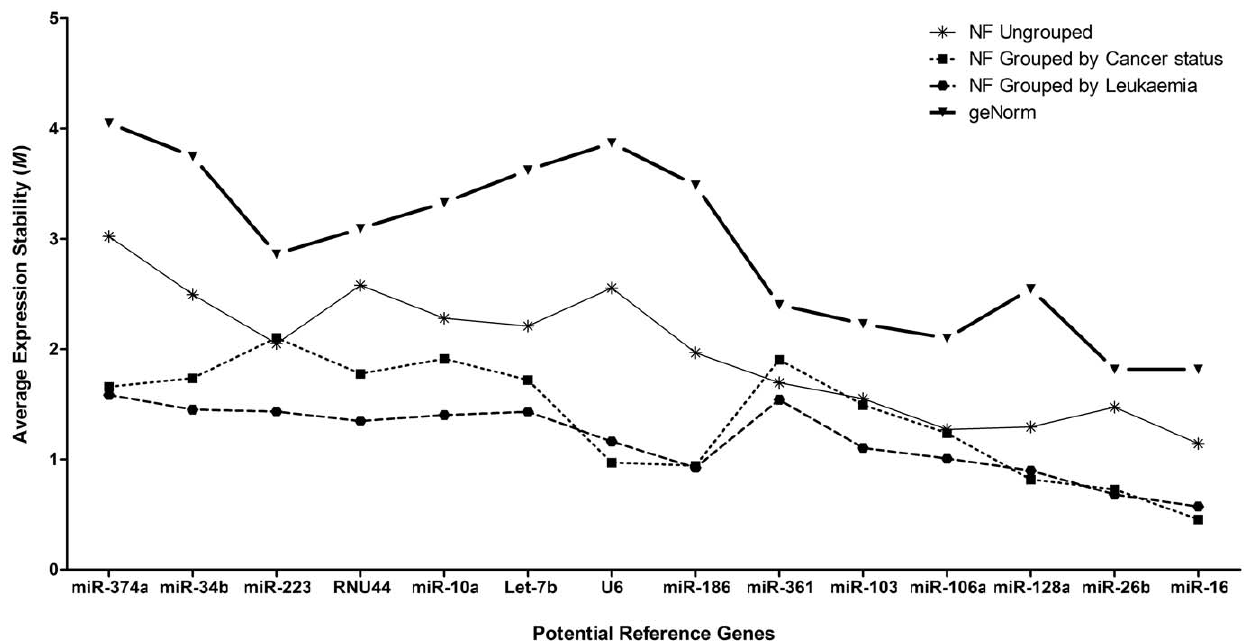
Figure 1. The stability of miRNA species expression in hematopoietic samples. The stability of miRNA species expression using 41 samples of leukaemic and non-leukaemic cell lines, paediatric archived bone marrow aspirate slides (Table S1), and 14 potential miRNA candidates (Table S2). geNorm and NormFinder (NF) were used to calculate the expression stability values for each miRNA tested. The most ‘stably’ expressed gene in a sample group is that with an average expression stability value ( M ) closest to zero. The most stably expressed miRNA were; NF Ungrouped: hsa-miR- 16 M =1.143; NF Grouped by Cancer Status: hsa-miR-16 M =0.457; NF Grouped by Leukaemia subtype: hsa-miR-16 M =0.573; geNorm: hsa-miR-16 and hsa-miR-26b are equal at M =1.817.